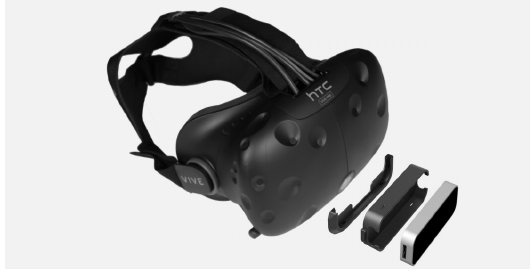
Figure 2. HTC Vive with a Leap Motion [24].